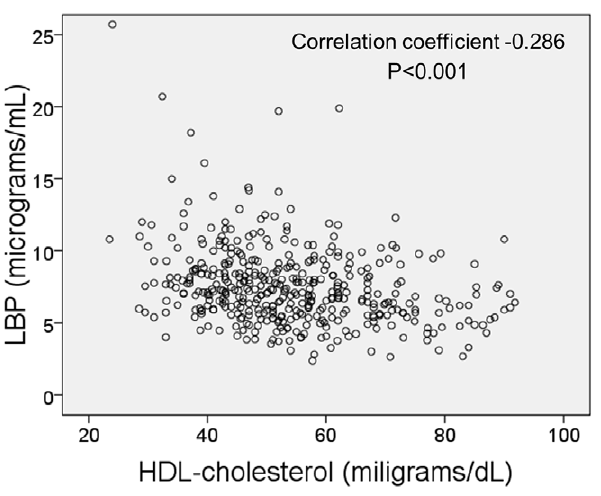
Figure 4. Scatterplot of individual concentrations of lipopoly- saccharide-binding protein (LBP) and HDL-cholesterol. Correla- tion coefficient was obtained with the Spearman’s rank test.